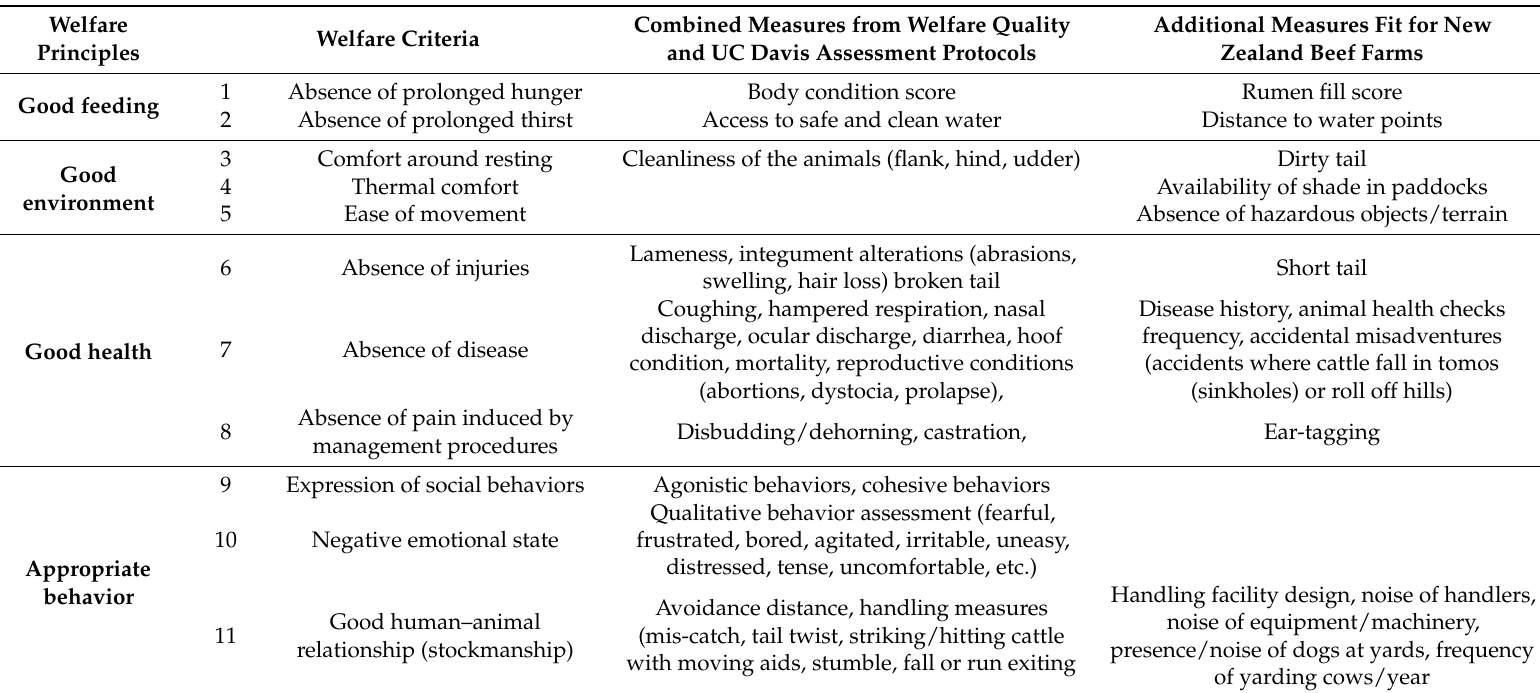
Table 3. All potential measures identified as suitable (selected measures amalgamated from Welfare Quality [6] and UC Davis [7] assessment protocols and additional measures fit for New Zealand extensive pasture-based beef cattle